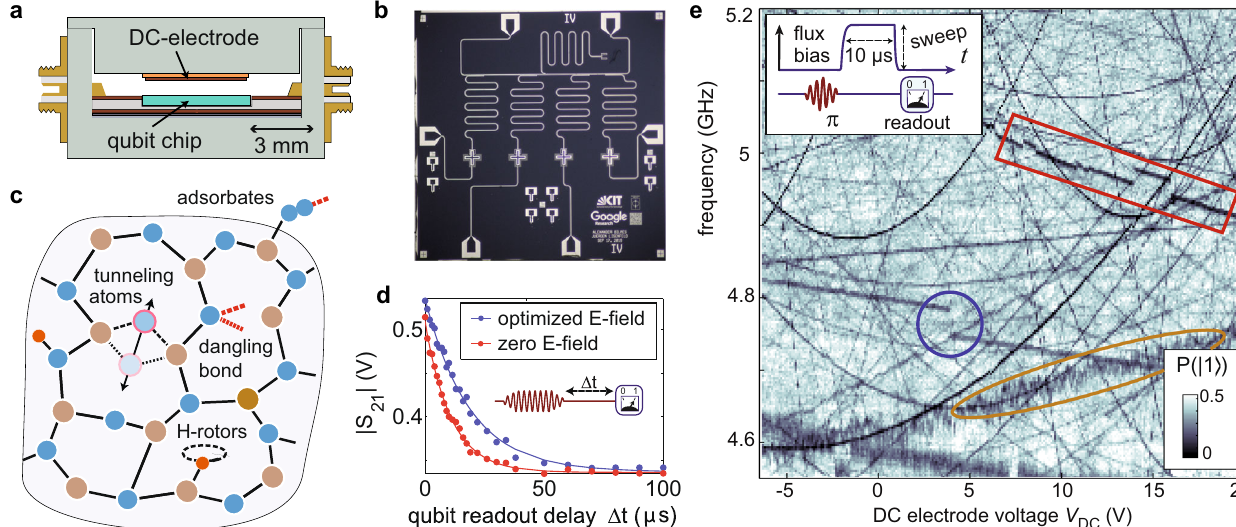
Fig. 1 Tuning defects by an electric fi eld. a Cross-section through the sample housing. The electrode to generate the E- fi eld consists of a Copper-foil/Kapton foil stack glued to the lid of the sample holder above the qubit chip, and voltage-biased against ground. b Photograph of the XMon qubit samples used in this work. c Illustration of defects which appear in the amorphous oxides of qubit electrodes. d Exemplary measurements of the decaying qubit population after a long exciting microwave pulse (see inset) to determine the T 1 time. Red (blue) points were acquired at zero (the optimized) applied E- fi eld. e Resonances of individual TLS (dark traces), observed as accelerated decay of the qubit ʼ s excited state population (color scale) using the swap-spectroscopy protocol shown in the inset. The circle marks coupling of a TLS to a metastable fl uctuator which may cause hysteresis in E- fi eld sweeps. Rectangle and ellipse indicate the fl uctuating resonance frequencies of TLS coupled to slowly and quickly fl uctuating thermal TLSs,